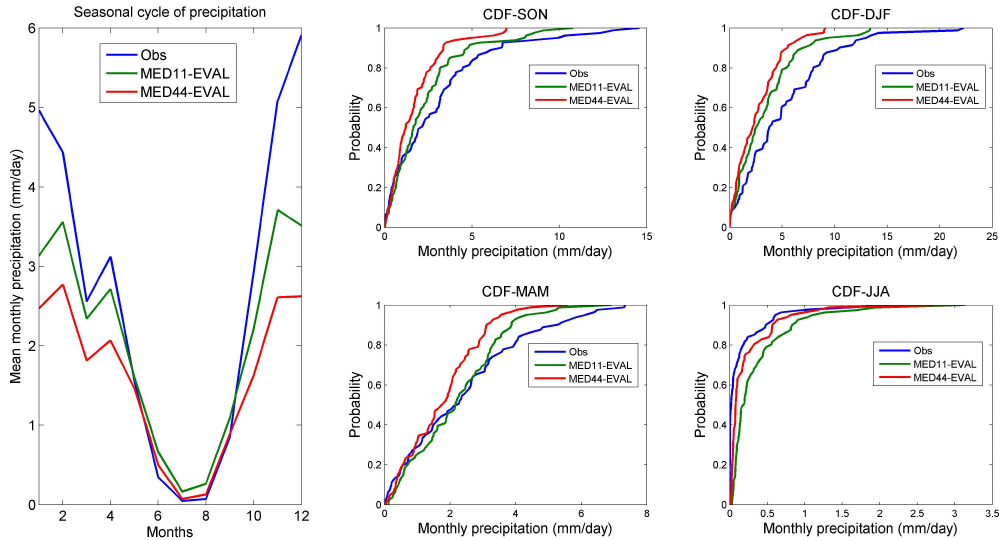
Fig. 4. Evaluation of the seasonal cycle (left panel) and seasonal cumulative distributions of monthly precipitation (right panels) of MED11- EVAL and MED44-EVAL (1984–2010).